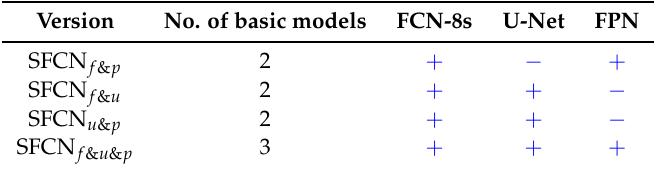
Table 2. Network setting of stacked fully convolutional networks from FCN-8s, U-Net, and FPN. Version No. of basic